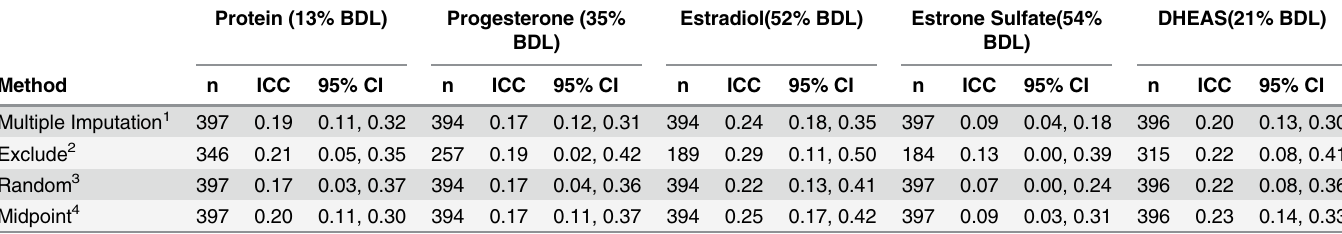
Table 5. Intraclass Correlation Coefficients (ICCs) and 95% Confidence Intervals (CIs) by Analyte and Statistical Method to Account for Observa- tions Below the Detection Limit (BDL).